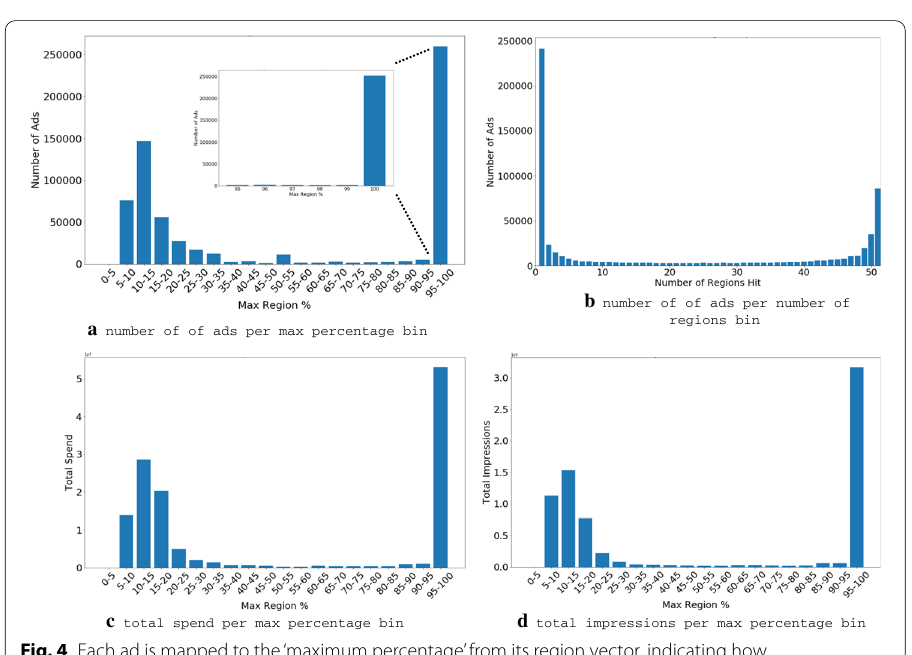
Fig. 4 Each ad is mapped to the ‘maximum percentage’ from its region vector, indicating how regionally-concentrated it is. If the max percentage is close to 100, it means that almost all impressions came from one region, while if it’s close to 0, it means that many regions impressed upon the ad. a Histogram of max percentage per ad; inset: zoom-in on the last bin showing that most ads in this bin get 100% of their impressions from one region. b Histogram of the number of regions that impressed upon the ad. c Histogram of the amount of estimated dollars spent on an ad versus its max percentage value. d Histogram of the estimated number of users who were shown an ad versus its max percentage